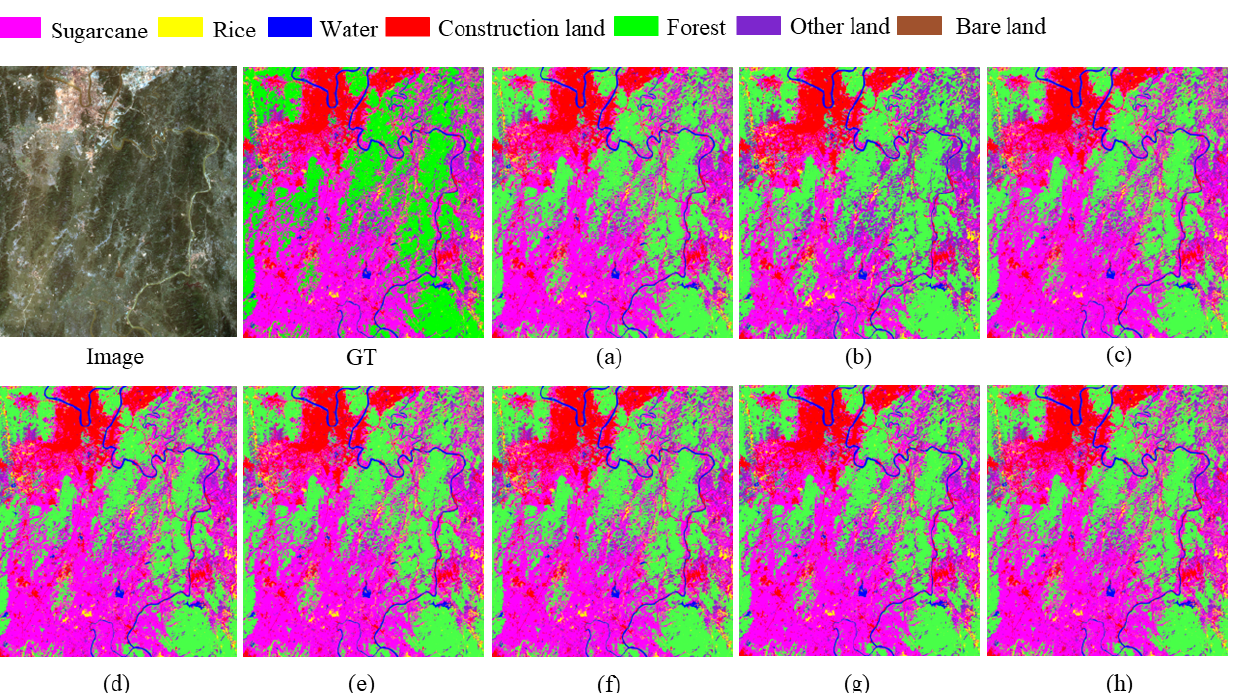
Figure 14. Semantic segmentation results on the test set in the 2017 dataset I produced by: ( a ) U-Net, ( b ) U-Net++, ( c ) SAR-UNet, ( d ) Res-UNet++, ( e ) Attention-UNet, ( f ) UCTransNet, ( g ) Swin-UNet, and ( h )